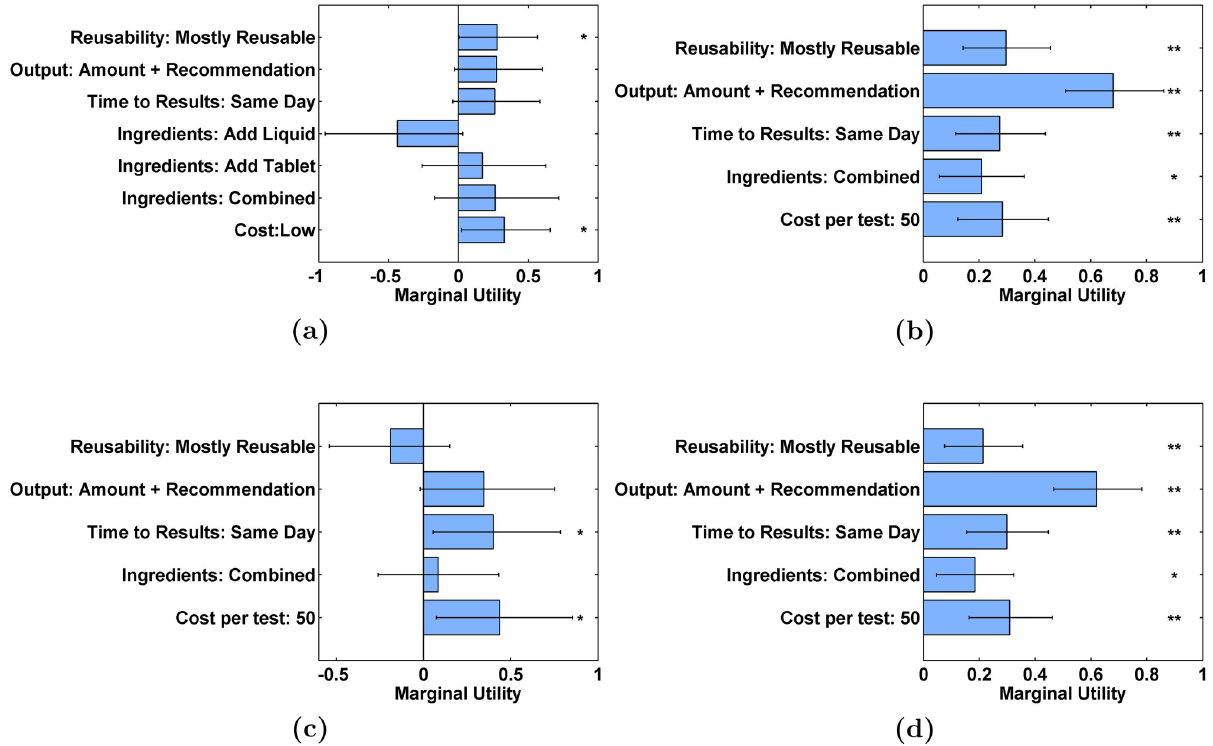
Fig 4. Conjoint analysis results. Conjoint analysis parameter estimates for (a) pilot conjoint analysis interviews (N = 10) (b) full conjoint analysis interviews of main population (no local contacts, N = 45) (c) full conjoint analysis interviews of local contacts (N = 8) (d) full conjoint analysis interviews of entire population (main population and local contacts, N = 53). Error bars are 95% confidence intervals. Asterisks are significance level, where � denotes p < 0.05 and �� denotes p < 0.005 according to a likelihood ratio test on each parameter estimate. Parameter estimates are tabulated for all levels in Tables H, I, J and K of S1